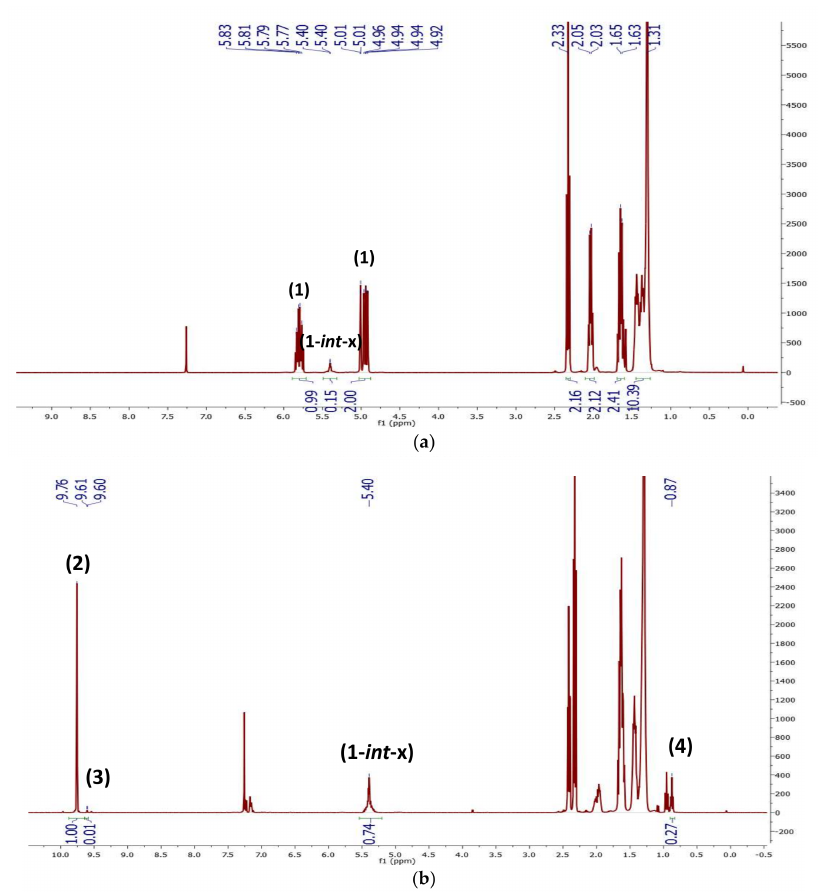
Figure A1. 1 H NMR spectrum (400 MHz, CDCl 3 , 23 ◦ C): ( a ) starting material 1 / 1- int -x ; and ( b ) reaction mixture at 100% conversion of 1 (bottom) (Table 1, entry